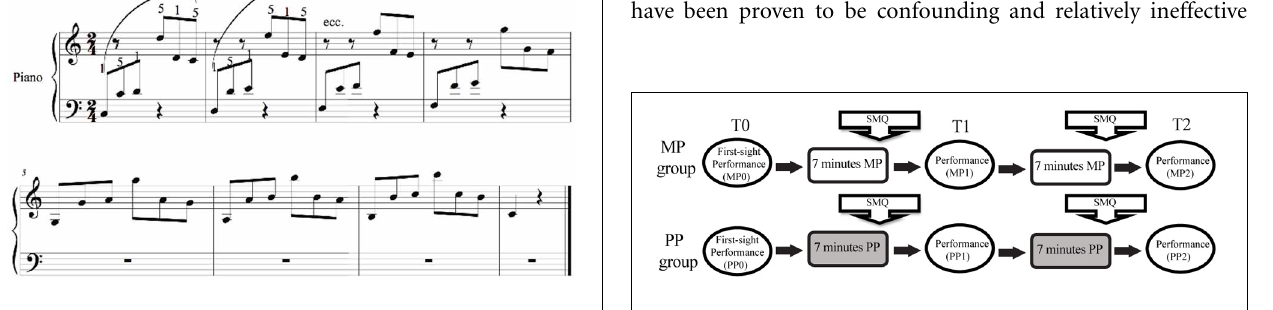
FIGURE 1 | Music piece. The numbers over the notes represent the constrained fingering (1 = thumb, 5 = little finger). The piece had to be performed at a speed of 112 beats/min for each quarter note.